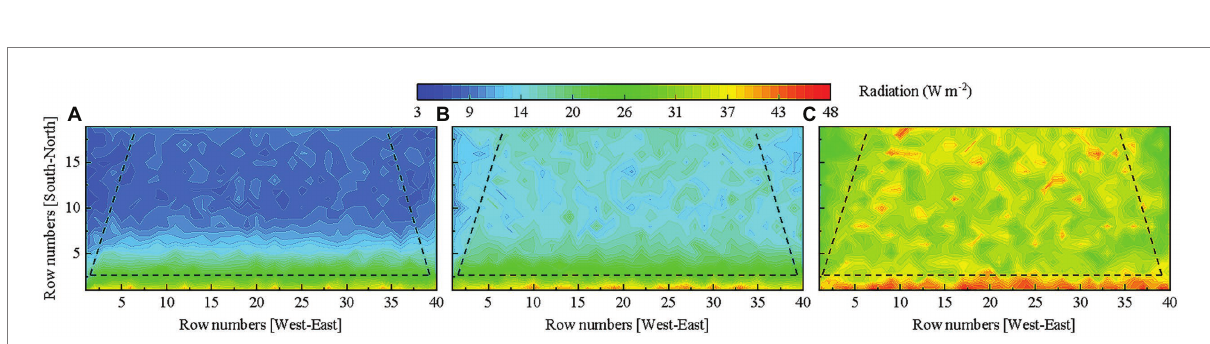
FIGURE 8 Light distribution in the (A) lower, (B) middle, and (C) upper layers of the tomato canopy on December 30th in the greenhouse without reflective films. Tomato canopy light interception in different areas of the greenhouse is separated by dashed lines for comparison.